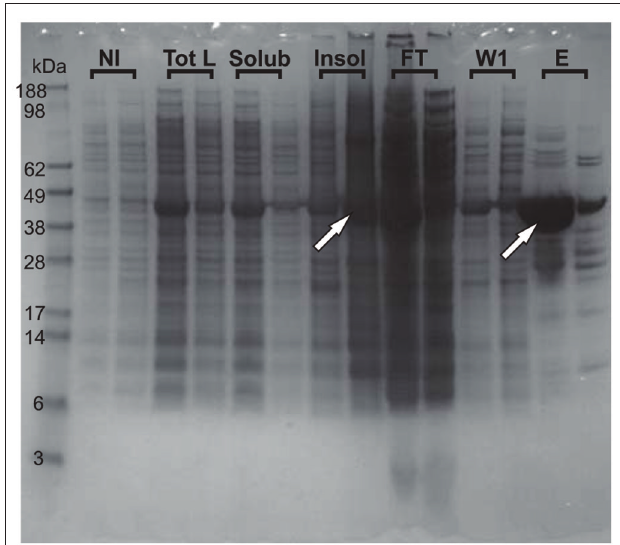
FIGURE 3 | Tendency of the G137V mutant to form inclusion bodies in bacteria . The wild-type and G137V mutant are compared on Nu-PAGE MES SDS gel. For each fraction (NI, Tot L, Solub, INSOL, FT, W1 and E), the first sample loaded is wild type and the second is G137V. NI stands for Non-Induced fractions (before induction with IPTG); Tot L: fractions after 3 h-induction with IPTG, Total Lysate; Solub: Soluble fraction of the previous Tot L; INSOL: Insoluble fraction corresponding to the inclusion bodies; FT: Flow Through after first step NI-NTA purification; W1: first Wash; E: Elution with 300 mM Imidazole. The arrows indicate retention of the G137V mutant in inclusion bodies explaining the lower final concentration of proteins obtained in the elution after the first step of purification compared to the wild-type